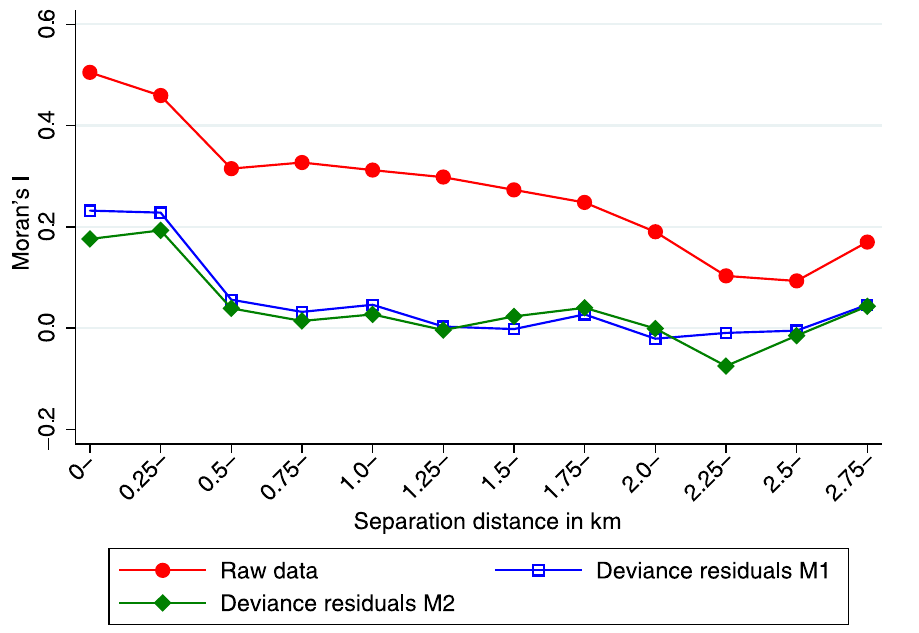
Fig 4. Spatial autocorrelation of T . trichiura infection between and within households in Kyela. The red line shows Moran’sI of spatialautocorrelation for the raw data. The blue and green lines show the autocorrelation of devianceresidualsfor the models M1 and M2, respectively.The horizontal axis shows the distancebandsbetweenhouseholds.